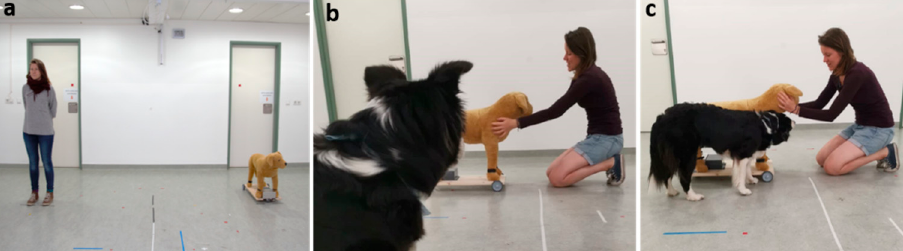
Figure 3. Different phases of each test trial (except for Exploration phase). Introduction phase ( a ), Interaction phase ( b ) and Reaction phase ( c ).